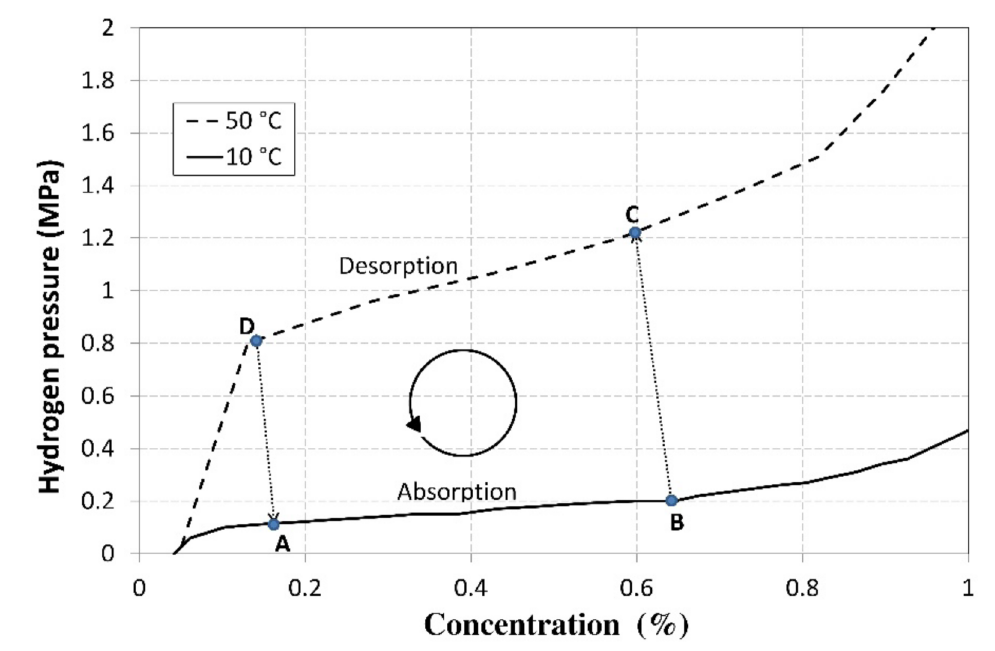
Figure 1. PCI characteristics of the La 0.85 Ce 0.15 Ni 5 alloy with a plotted operating cycle of the